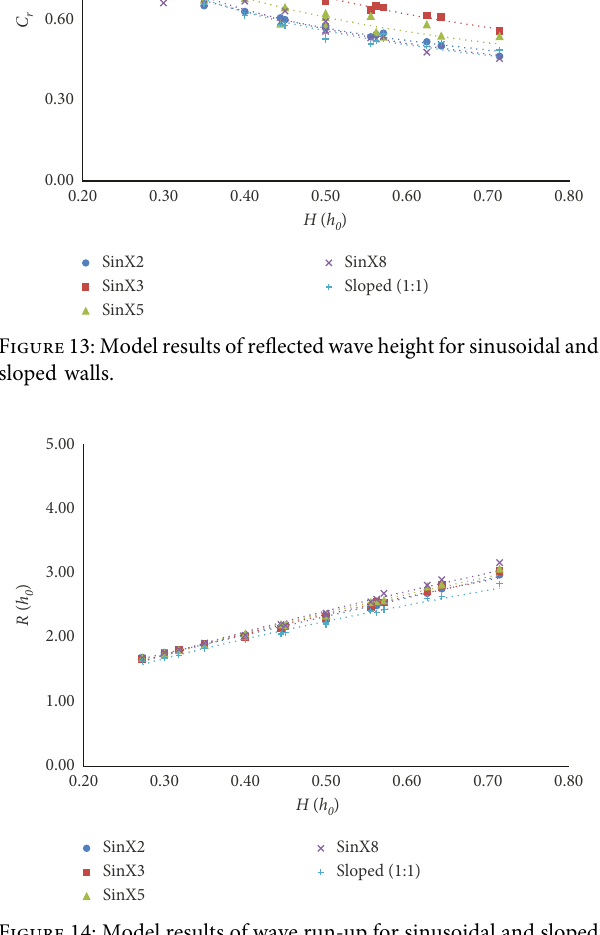
Figure 14: Model results of wave run-up for sinusoidal and sloped walls.